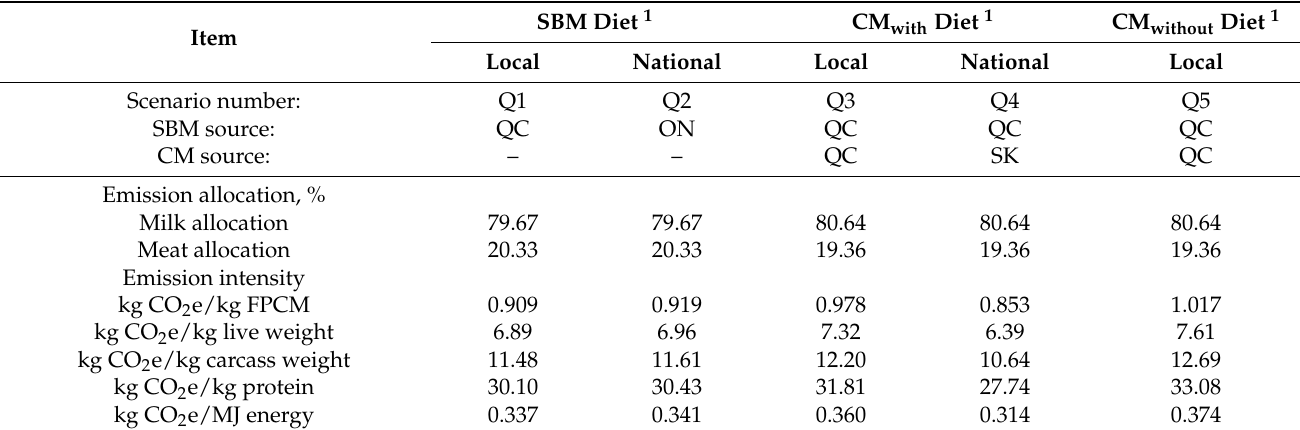
Table 6. Greenhouse gas emission intensity of milk and meat produced by a dairy farm in Quebec using soybean meal (SBM) or canola meal (CM) sourced locally and nationally, with (CM with ) and without (CM without ) the enteric methane mitigating effect of CM, in the diets of the lactating cows. SBM Diet